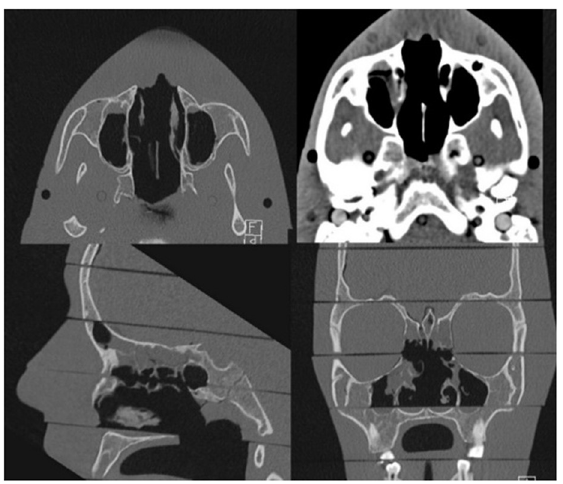
Fig 1. Example image panel of the online survey consisting of three CT-images in bone window in all three spatial directions and a single axial slice in a soft tissue window.